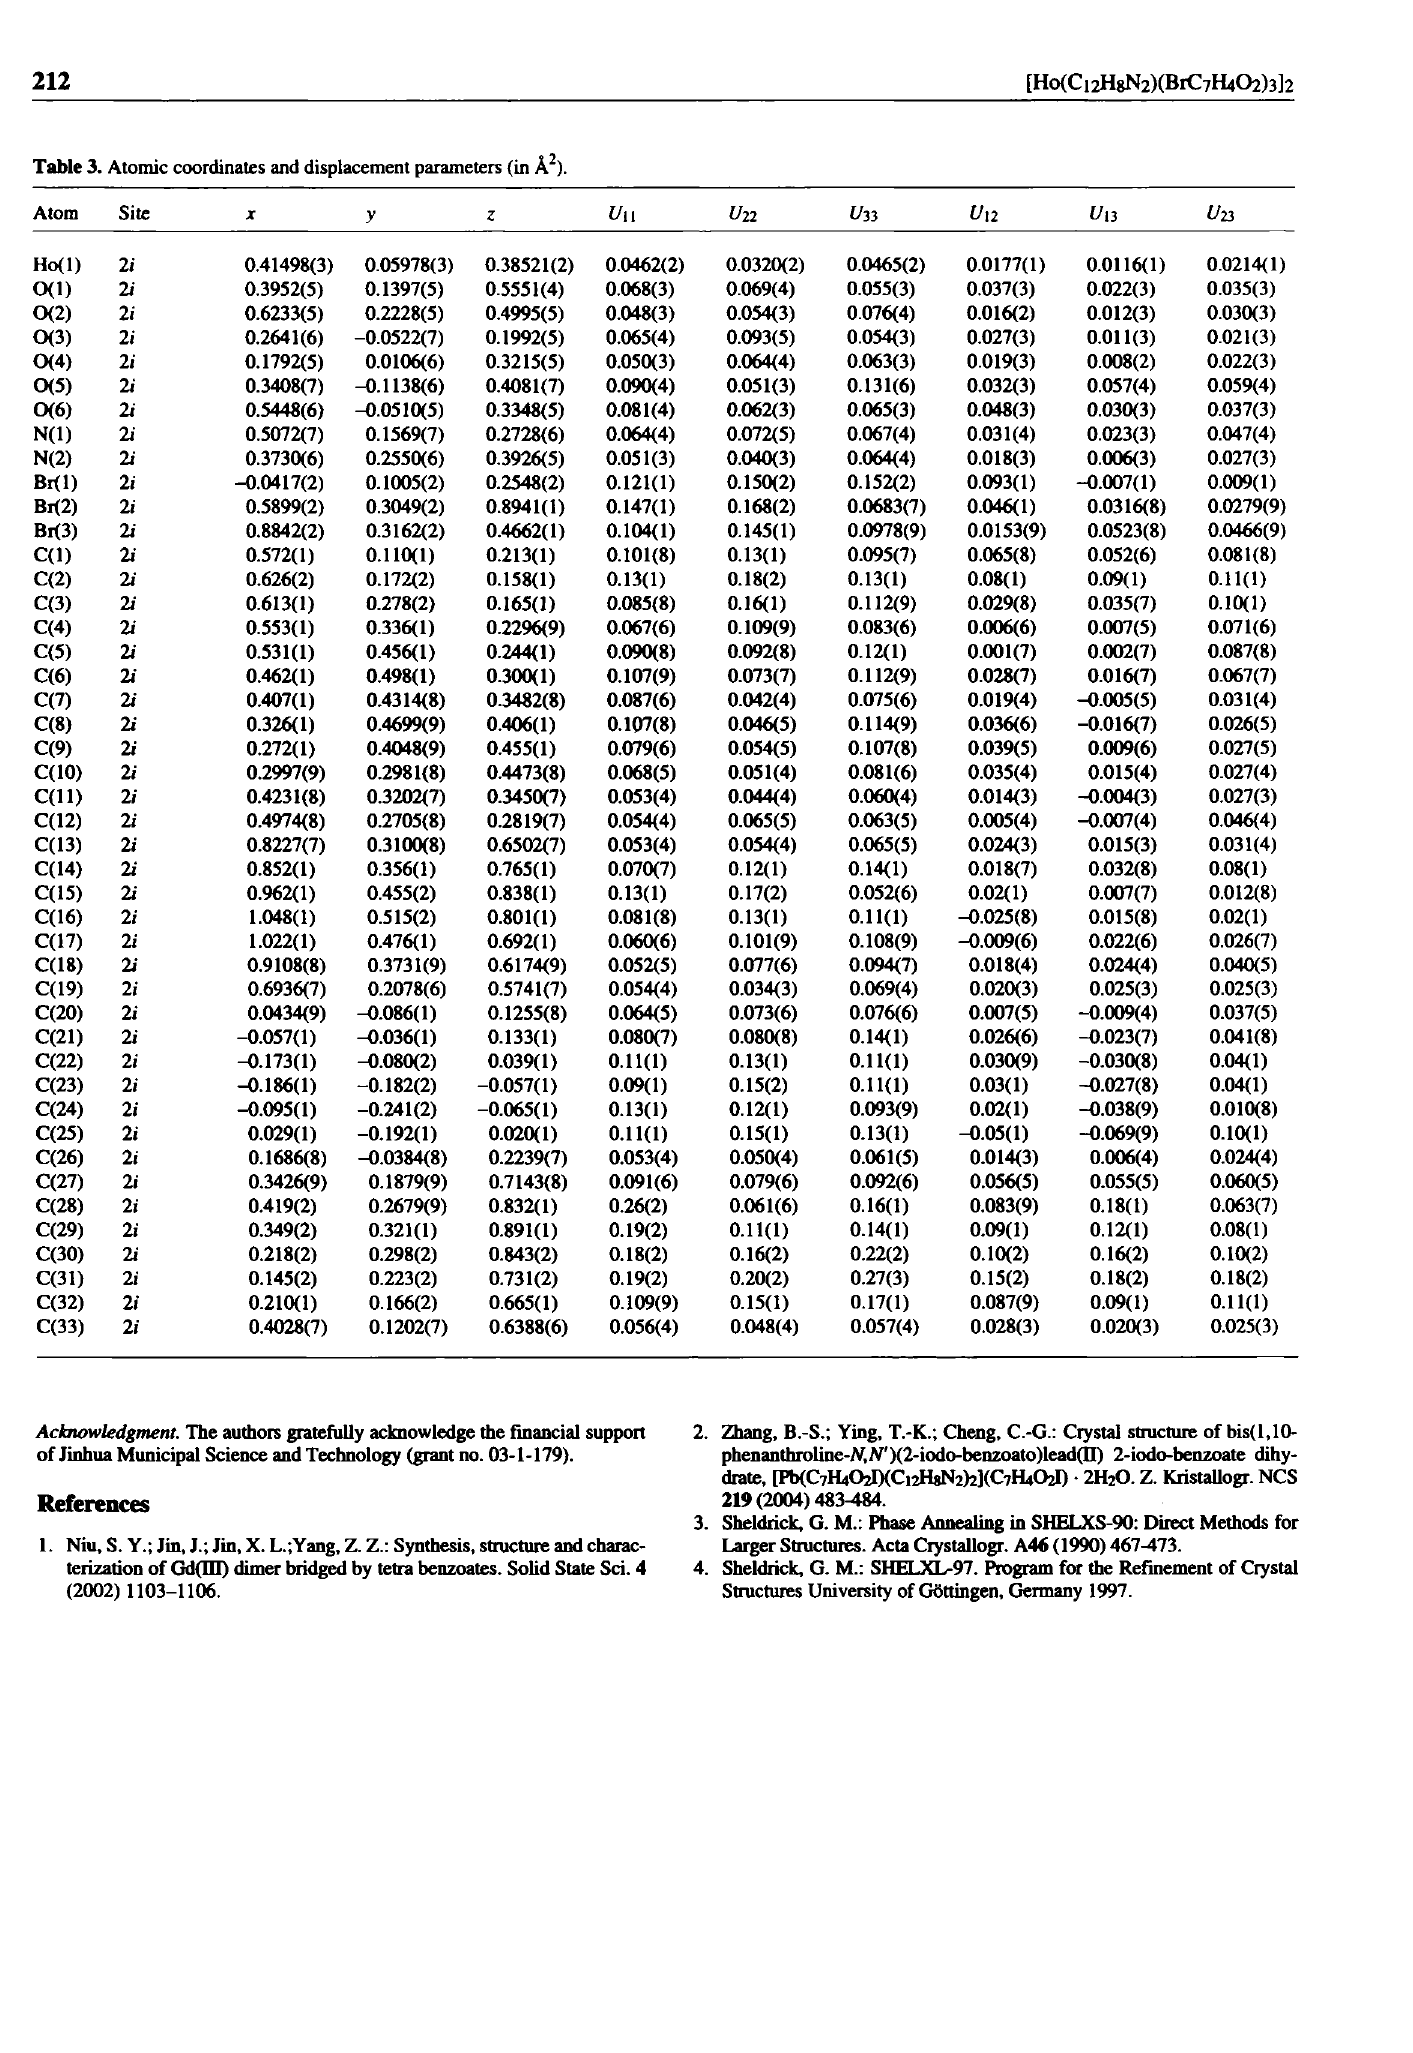
Table 3. Atomic coordinates and displacement parameters (in Ä 2